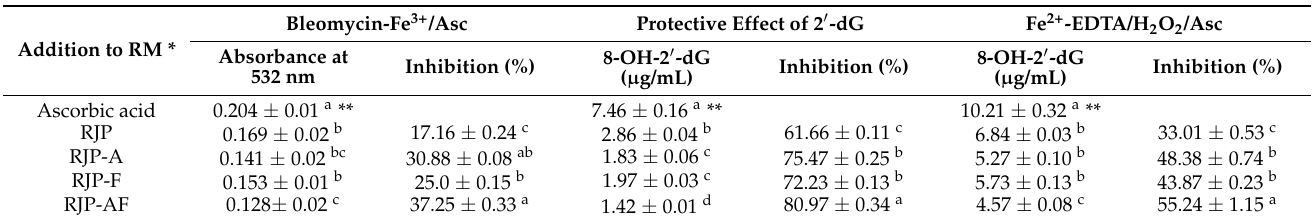
Table 4. Effect of royal jelly protein and different hydrolysates obtained by alcalase and flavourzyme on the DNA damage induced by bleomycin-Fe 3+ /Asc and oxidation of 2 (cid:48) -dG to 8-OH-2 (cid:48) -dG induced by Fe 2+ -EDTA/H 2 O 2 /Asc.